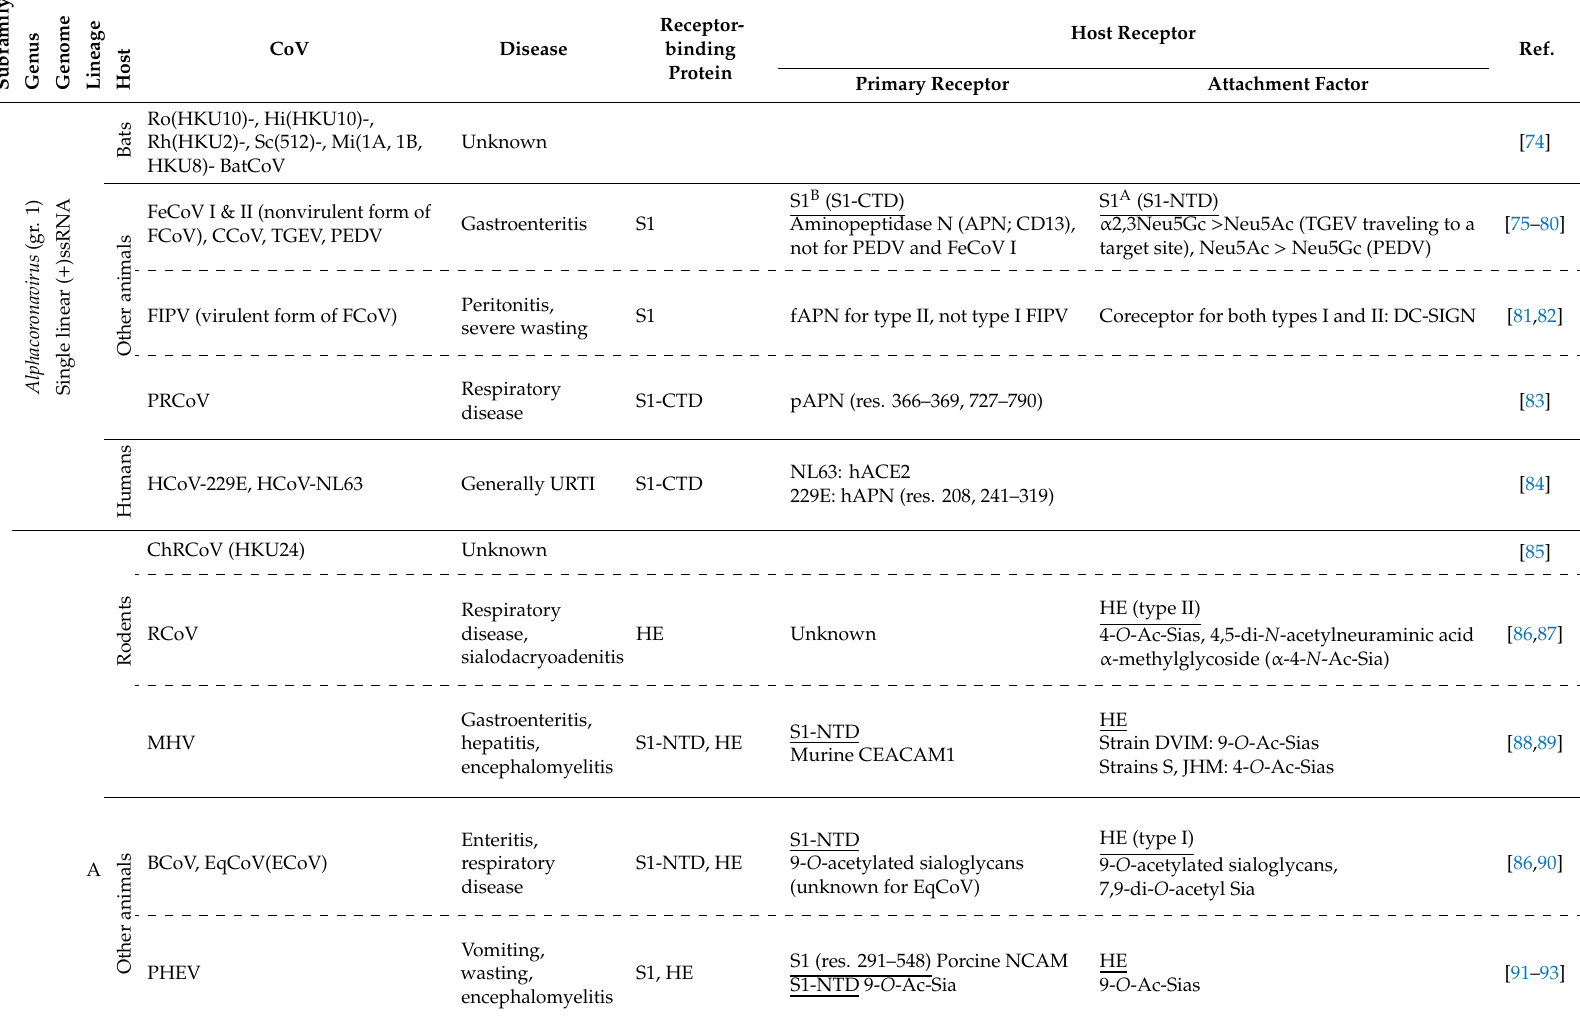
Table 2. Host range, viral receptor-binding glycoproteins and host receptors of